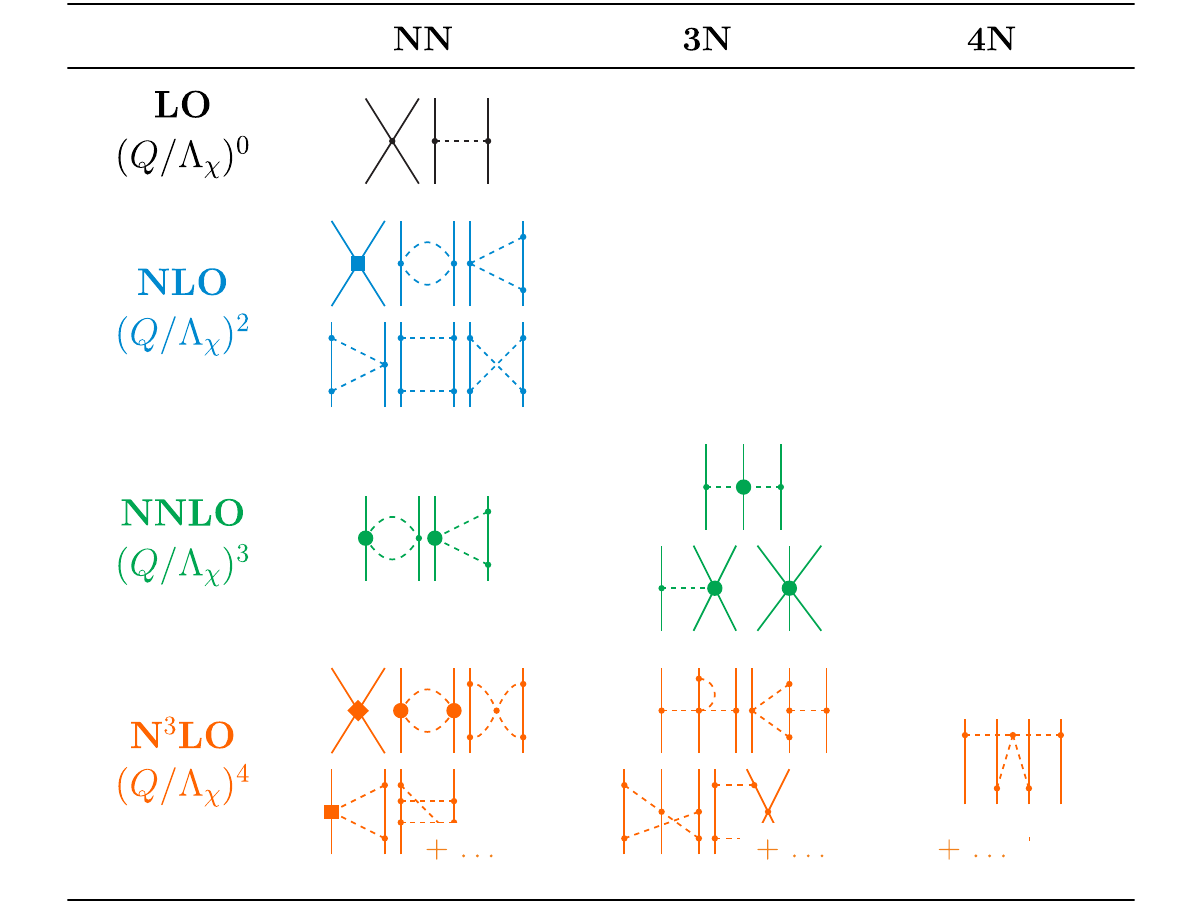
FIGURE 2 | Chiral two-, three-, and four nucleon forces through next-to-next-to-next-to-leading order (N 3 LO) (see, e.g., [2, 37, 38]). Dashed lines represent pion exchanges between nucleons. The large solid circles, boxes and diamonds represent vertices that are proportional to low-energy constants (LECs) of the theory (see